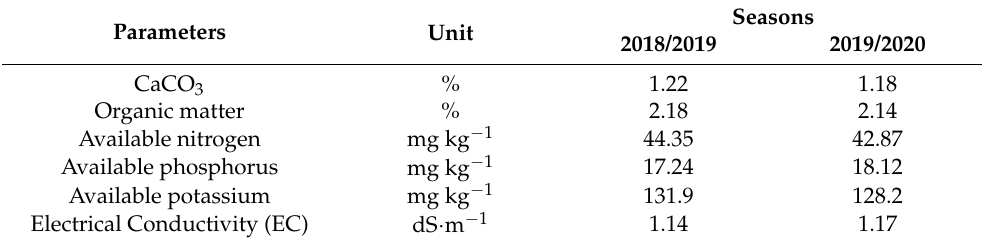
Table 2. Chemical properties of the soil used.